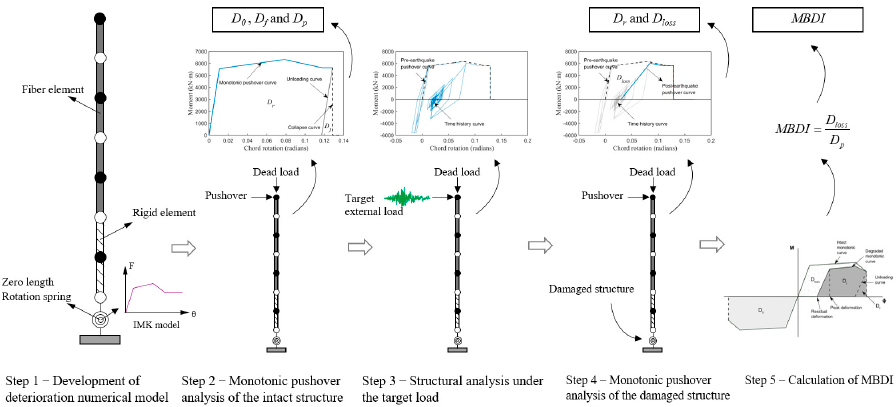
Figure 2. Flow chart of the proposed procedure for the FE − based quantification of MBDI.